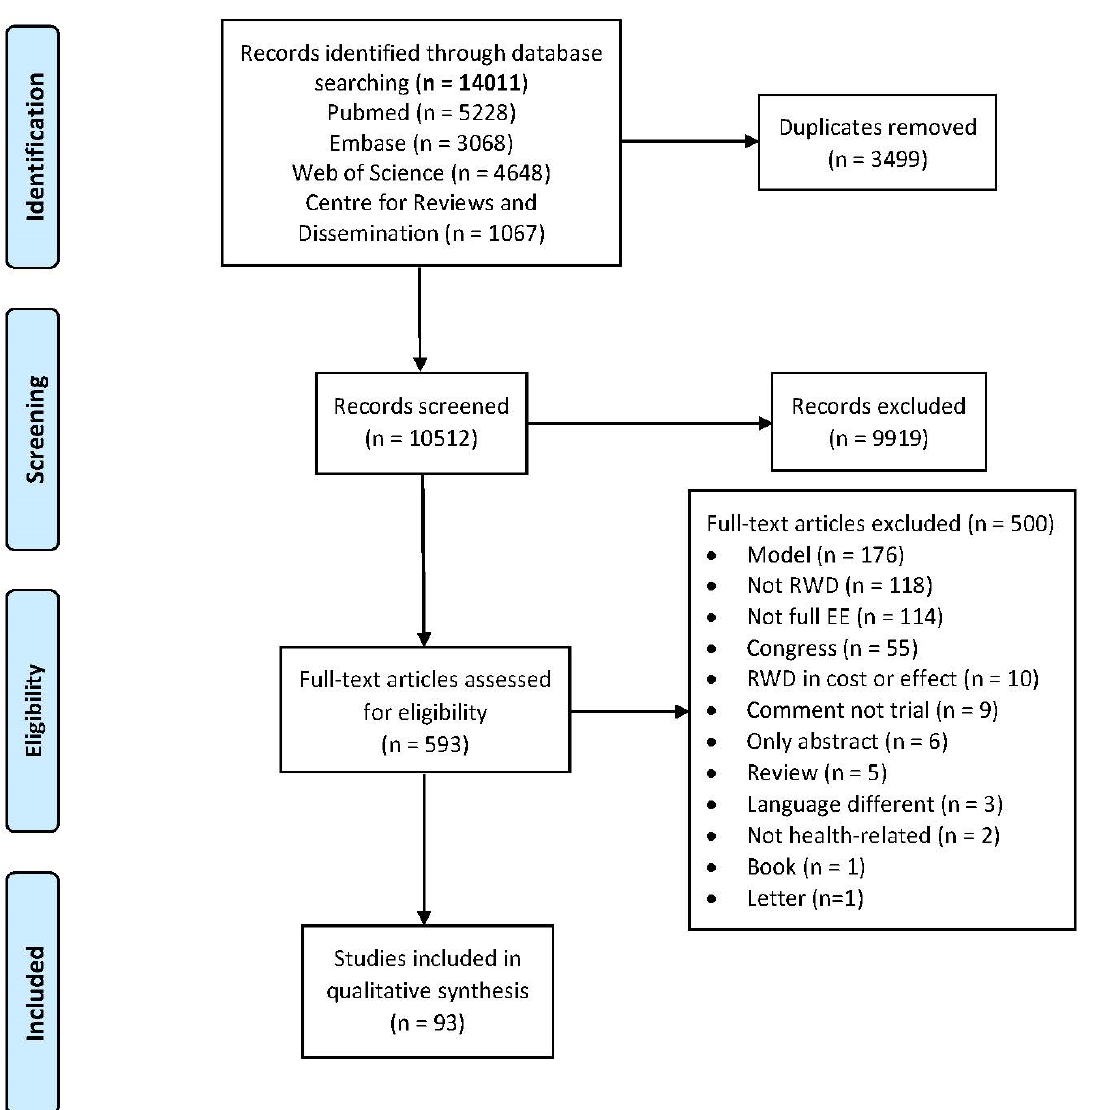
Figure 1. Flow chart of paper selection. Table 1. Characteristics of studies included.